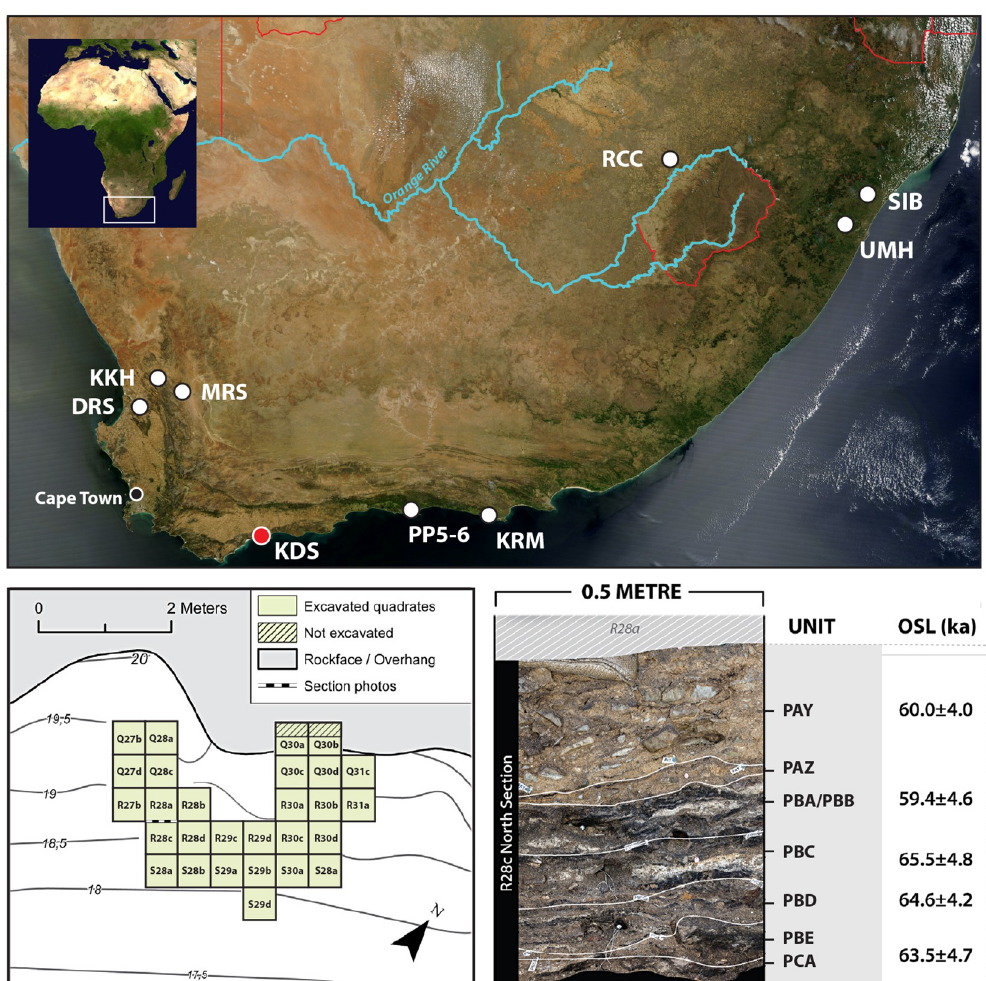
Fig 1. Location of KDS and other sites mentioned in the text. KKH: Klein Kliphuis; DRS: Diepkloof Rock Shelter; MRS: Mertenhof Shelter; KDS: Klipdrift Shelter; PP5-6: Pinnacle Point Site 5–6; KRM: Klasies River Mouth; RCC: Rose Cottage Cave; UMH: Umhlatuzana; SIB: Sibudu Cave. Satellite images modified after NASA, MODIS Rapid Response Team image, public domain. Location of excavated quadrates within KDS and simplified illustration of KDS HP stratigraphy (modified after